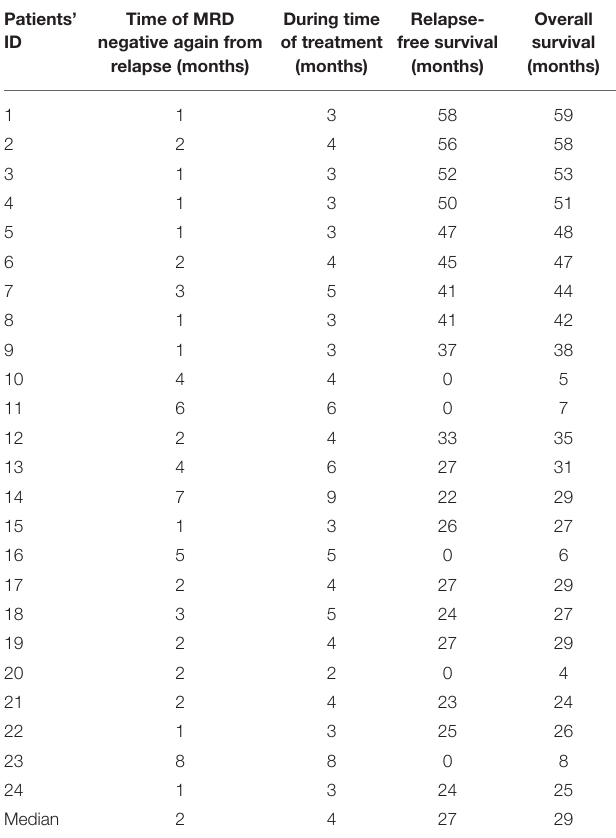
relapse compared with that of patients remaining in